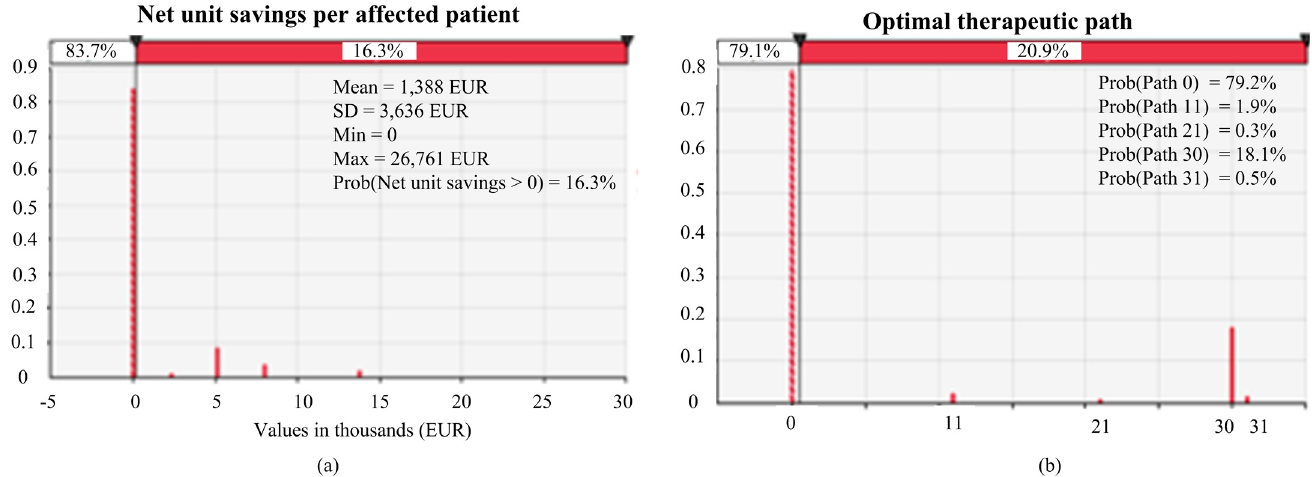
Figure 2. Net unit savings per affected patient ( a ) and optimal therapeutic path with the adoption of the cost decision-making model ( b ).